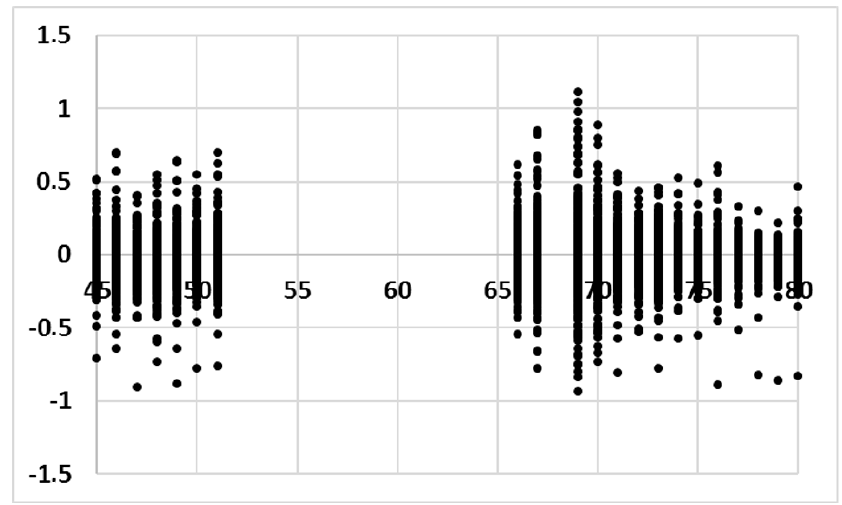
Figure 7. Residuals of the model (vertical axis) depending on the sensor (horizontal axis).